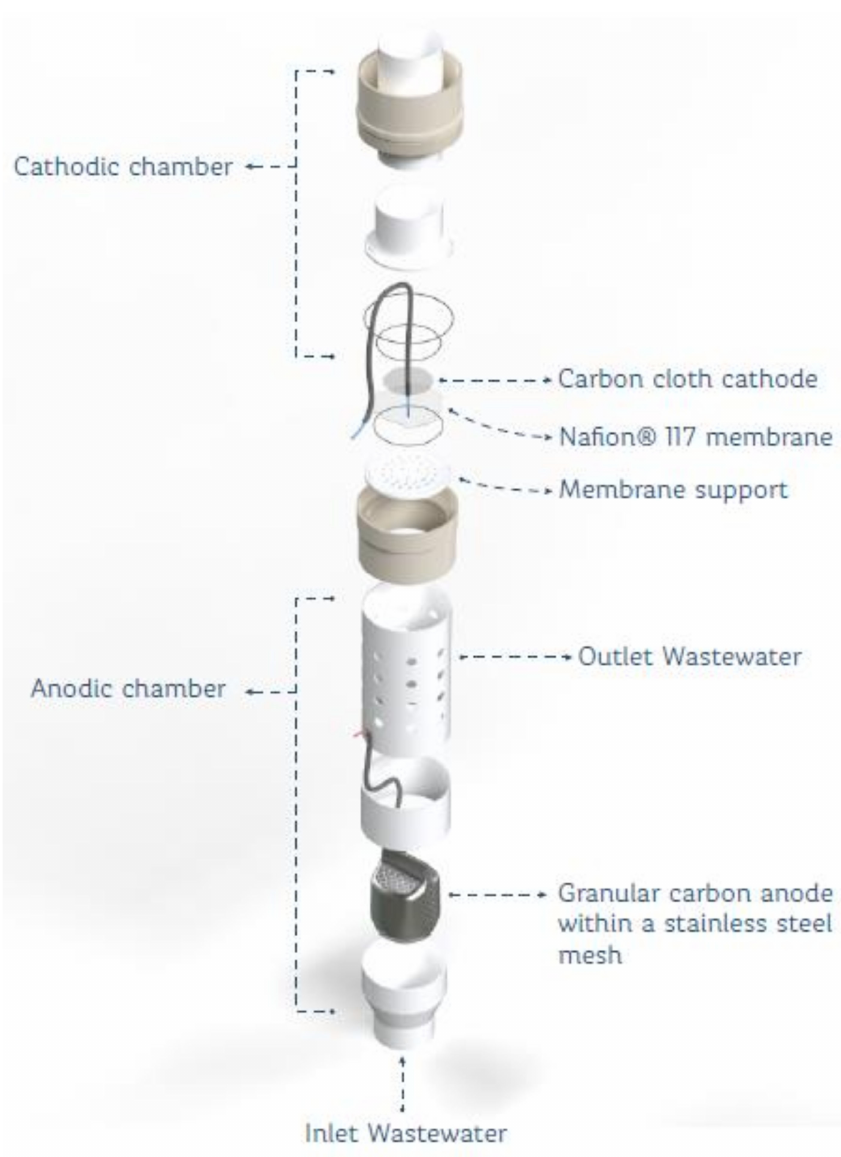
Figure 2. Microbial fuel cell (MFC) components and assembly for the 18 cells used in the